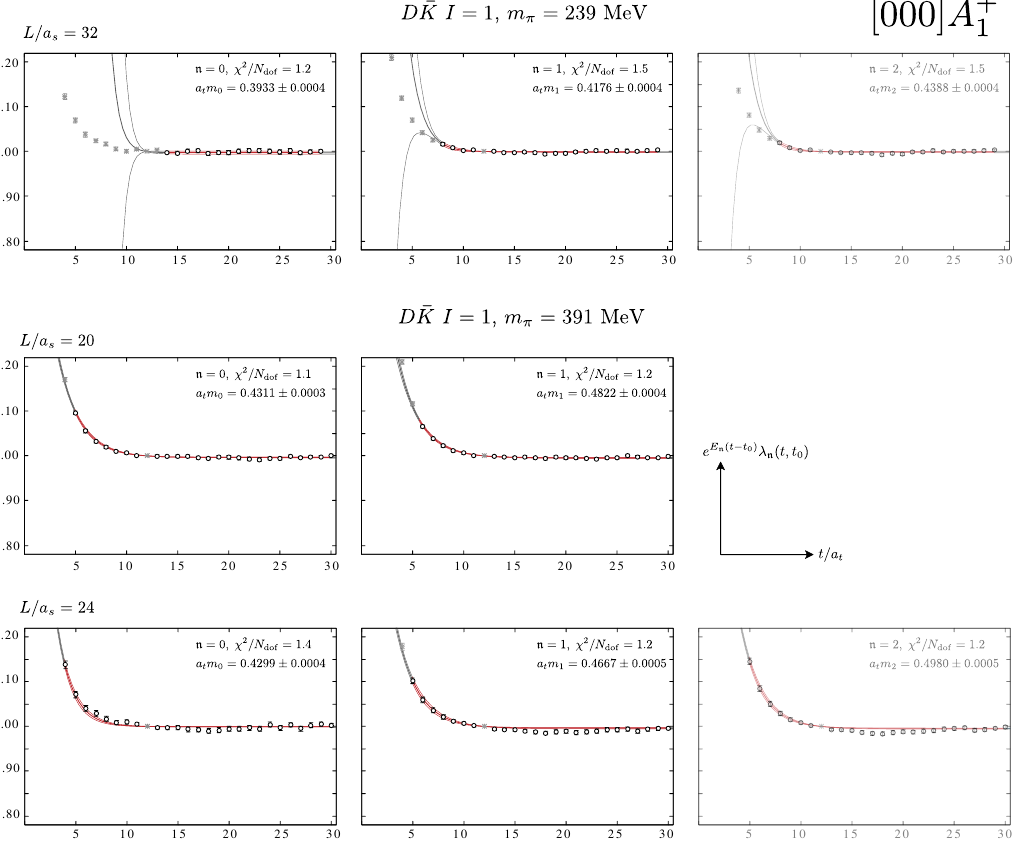
Figure 22 . As figure 20 but for D ¯ K I = 1 . These correspond to levels shown in figures 5 and